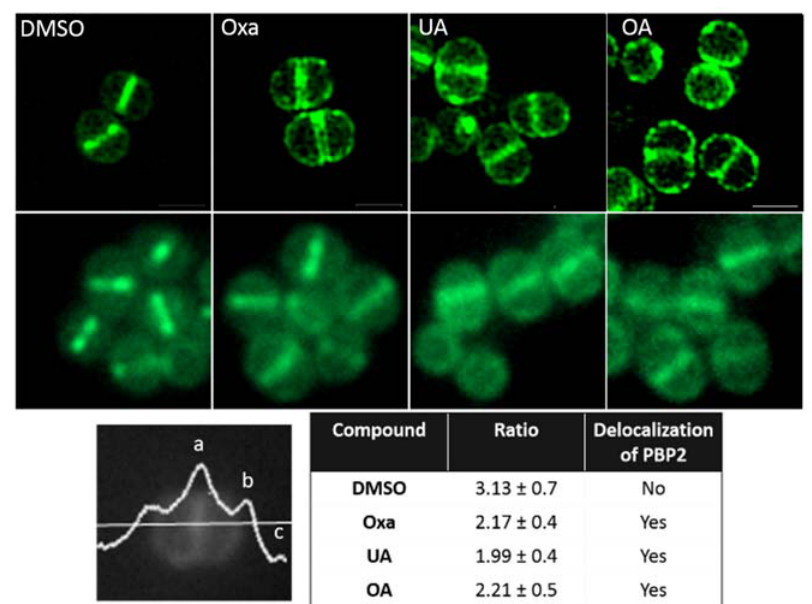
Figure 3. Influence of oxacillin and triterpenic acids on PBP2 localization. MRSA BCBPM073 carrying a gfp ‐ pbp2 fusion was grown in TSB and incubated during 30 min without (DMSO) or with 1x MIC of Oxacillin (Oxa), UA or OA and observed by conventional (lower panel) and superresolution structured illumination (upper panel) microscopy. The localization of PBP2 was determined by calculating the fluorescence ratio (FR) ( a – c )/( b – c ) where “ a ” corresponds to the fluorescence found at the septum, “ b ” to the fluorescence of the peripheral membrane and “ c ” to the background fluorescence [23], as illustrated in the lower part of the figure. Values are the means ± SD from measurements of fluorescence ratios of 200 cells in each sample. A FR value >2 indicates an enrichment at the septum [where membranes from two adjacent daughter bacteria are apposed] and values ≤ 2, a localization spread over the entire membrane. Statistical analysis: one ‐ way ANOVA with Dunnett’s post hoc test: FR values for bacteria exposed to Oxa, UA, or OA were different ( p < 0.01) from the control.